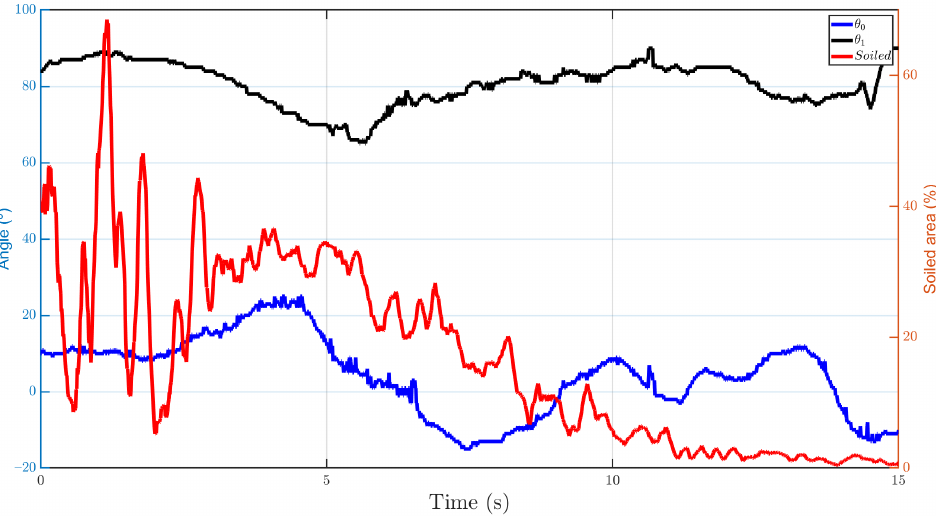
Figure 15. Joint variables and percentage of soiled area cleaned over time by the cleaning